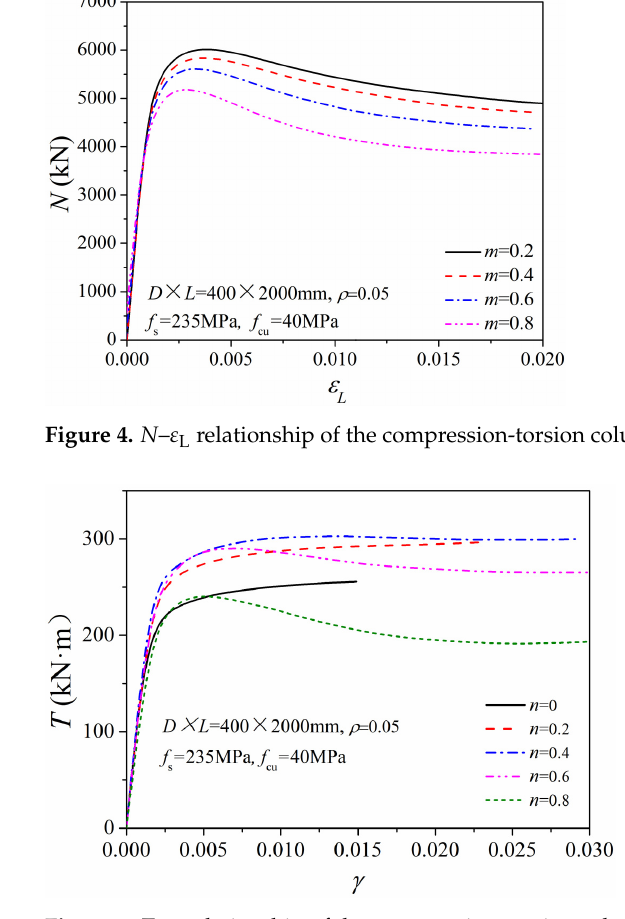
Figure 5. T – γ relationship of the compression-torsion columns.